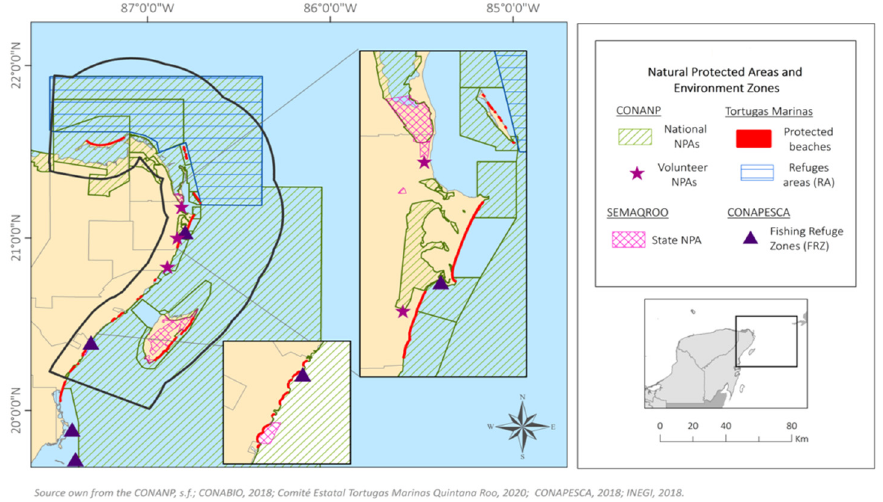
Figure 5. Protected Areas.